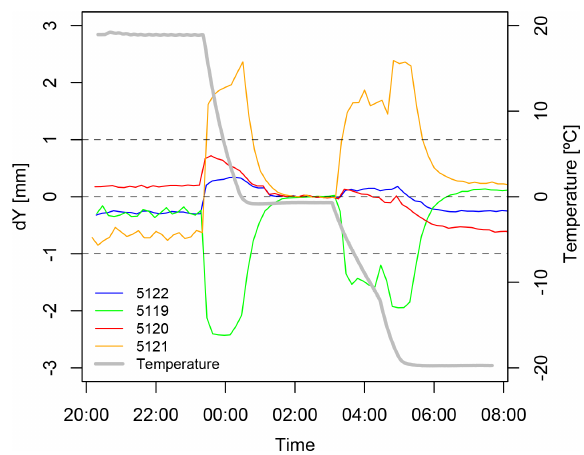
Figure 4. Tilt measured by differing sensors in the laboratory. The instruments, identified by their serial numbers, have not been moved during the experiment; instrument 5119 is not used in the field. In- clination is expressed as equivalent elevation change d Y assuming an arm of length 1.5m as is used in the